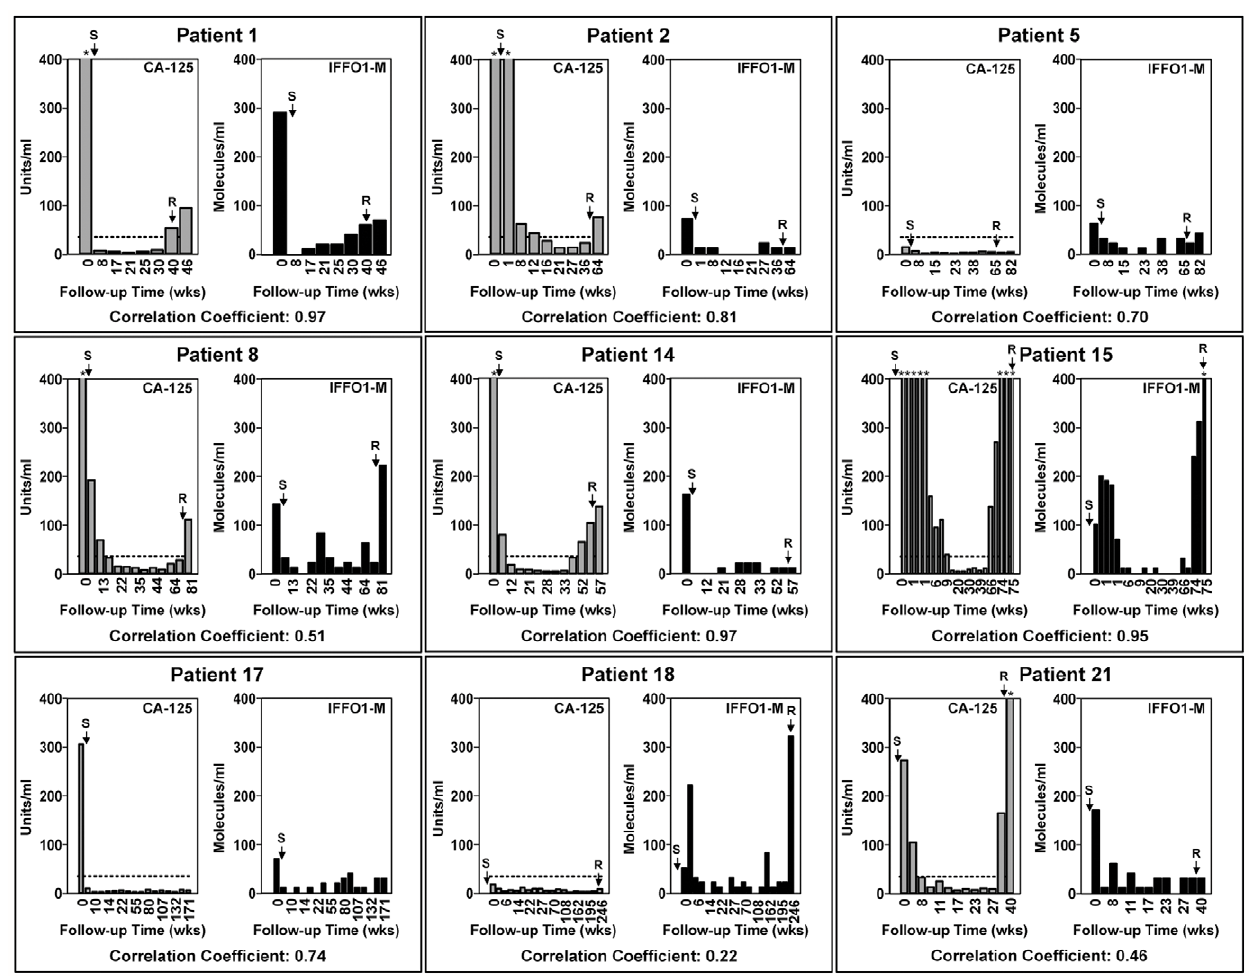
Figure 6. Comparison between the CA-125 and IFFO1-M performance in serially collected serum samples of nine ovarian cancer patients. Blood collected from ovarian cancer patients at the time of surgery (baseline samples) and at subsequent follow-up visits was used to measure CA-125 and IFFO1-M levels. The CA-125 levels (gray bars) are expressed in units/ml of blood, and the IFFO1-M methylation levels (black bars) are expresses as number of detected molecules/ml of sera on the Y-axis. The methylation analysis was performed using Digital MethyLight in DNA extracted from 100 m l of serum. The number of weeks since the baseline sample was collected is represented on the X-axis. The horizontal dashed line set at 35 u/ml represents the normal cut off value for CA-125. All patients except patients # 5 and # 18 had elevated levels of CA-125 in the baseline samples ( . 35 u/ml). The arrow labeled S indicates the time of surgery and the arrow labeled R indicates the time of tumor relapse as determined by CA-125 and/or imaging techniques. Due to the large range of CA-125 values we restricted the Y-axis to a scale of 400 for both of the markers, and we indicated the measurements that exceeded this scale by an asterisk. The values for these determinations are listed in the Table S4.